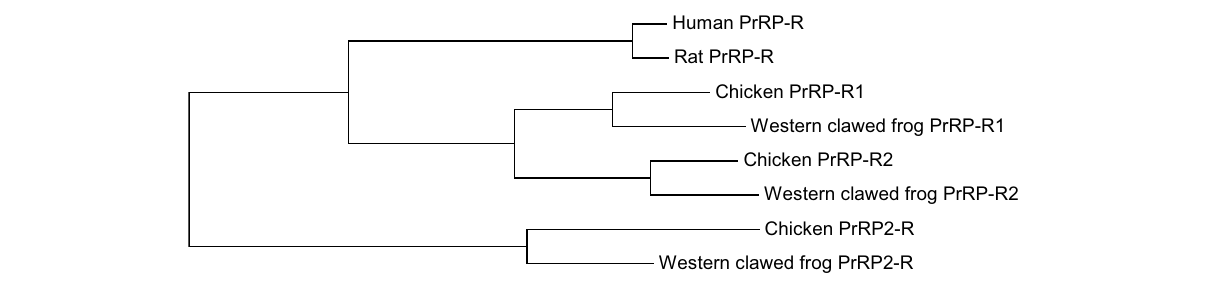
Xenopus and chicken PrRP2-R also show lower homology to their PrRP-R1 and PrRP-R2, respectively.